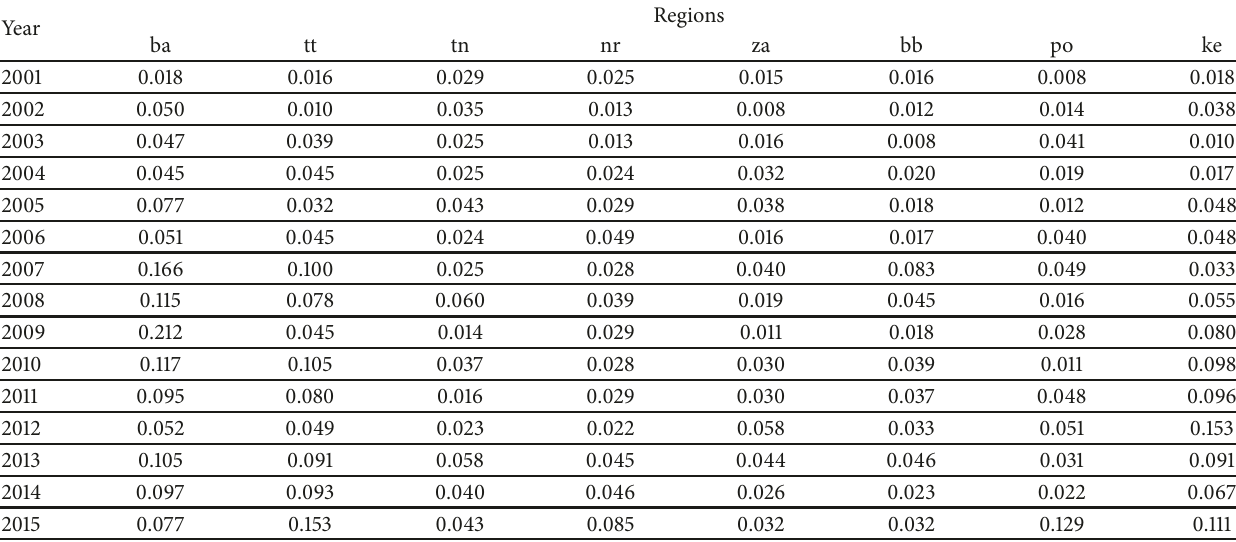
Table 3: Potential gains in life expectancy (in years) at birth (age 0) by complete elimination of Alzheimer’s disease for Slovak regions. Year